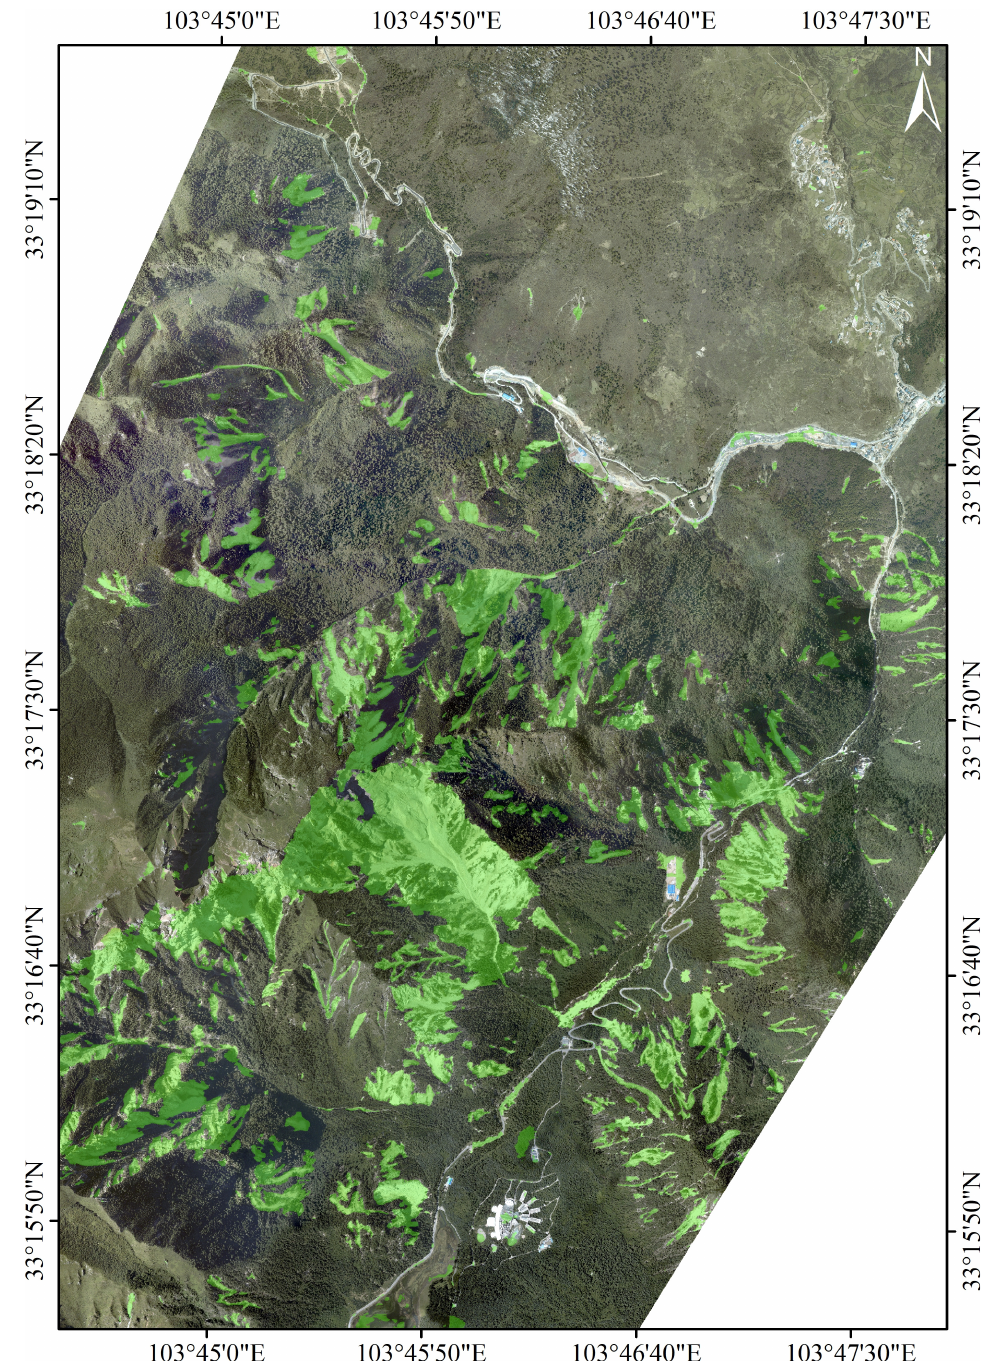
Figure 7. Visualization results of the LandsNet model. Green areas represent the predicted